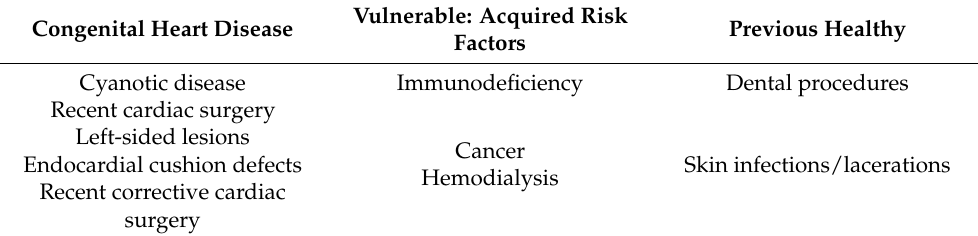
Table 1. Predisposing factors of infective endocarditis in